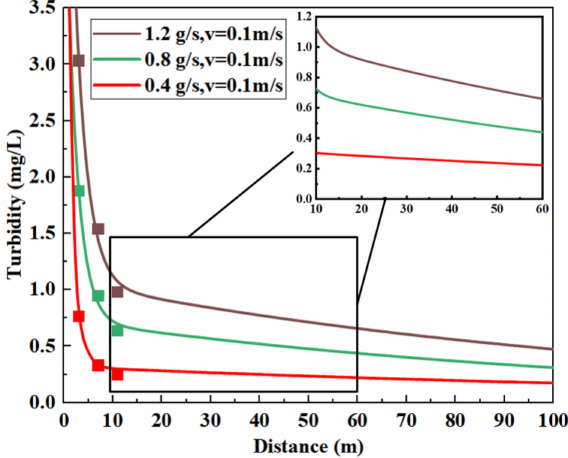
Figure 5. Turbidity as a function of the distance from the sediment source measured experimentally.